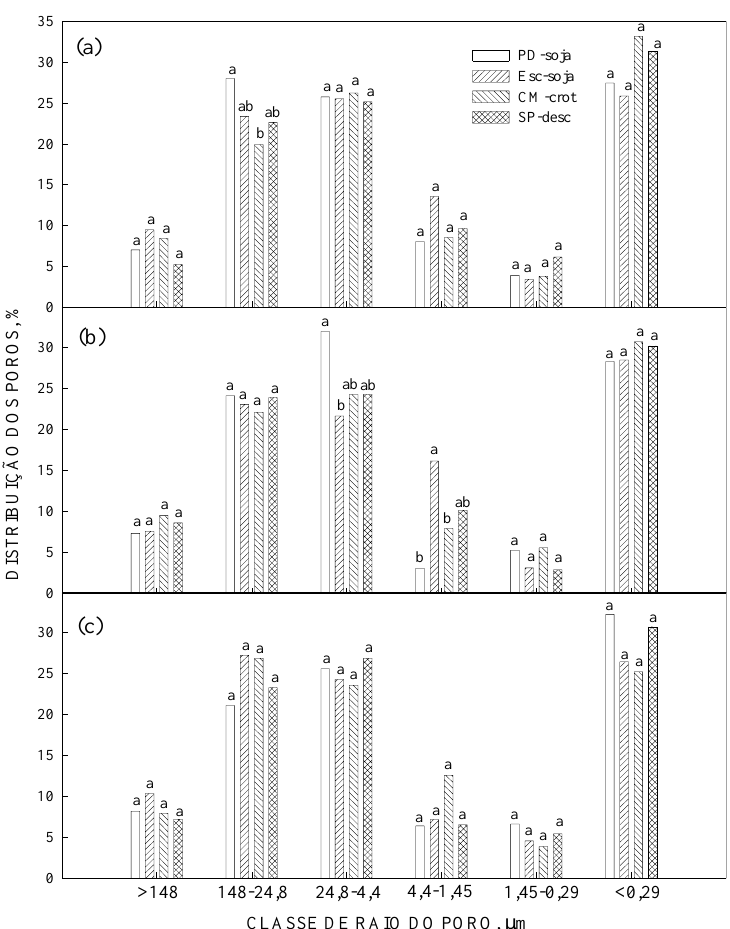
Figura 2. Distribuição de tamanhos de poros (fração relativa da porosidade total) para as profundidades de 0,02 a 0,05, 0,12 a 0,15 e 0,35 a 0,38 m em solo sob diferentes sistemas de manejo. Médias seguidas de mesma letra não diferem estatisticamente entre si pelo teste DMS a 5 % de